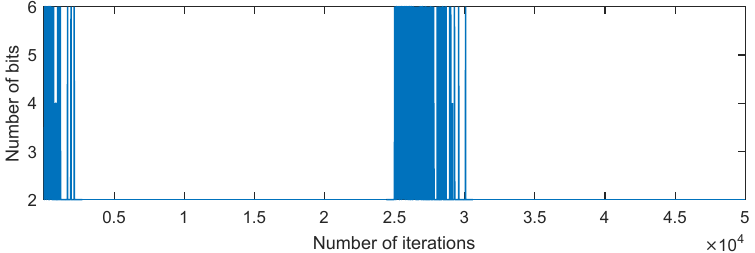
Figure 3. Number of bits used to encode the error in the proposed algorithm.